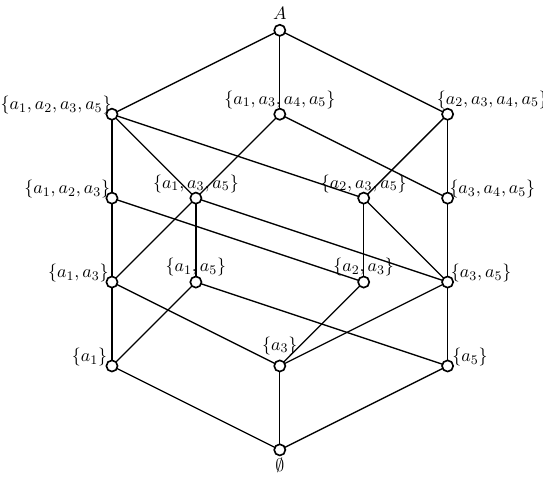
Figure 1. The lattice of the topology T ( R A ) of Example